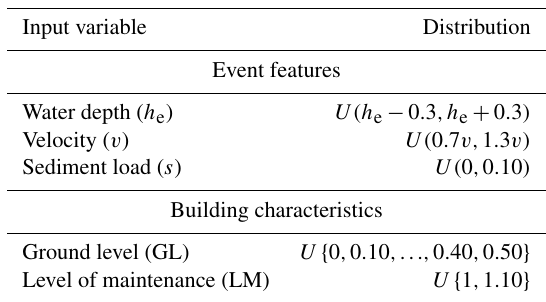
Table 5. Distributions adopted for the input variables in the valida- tion